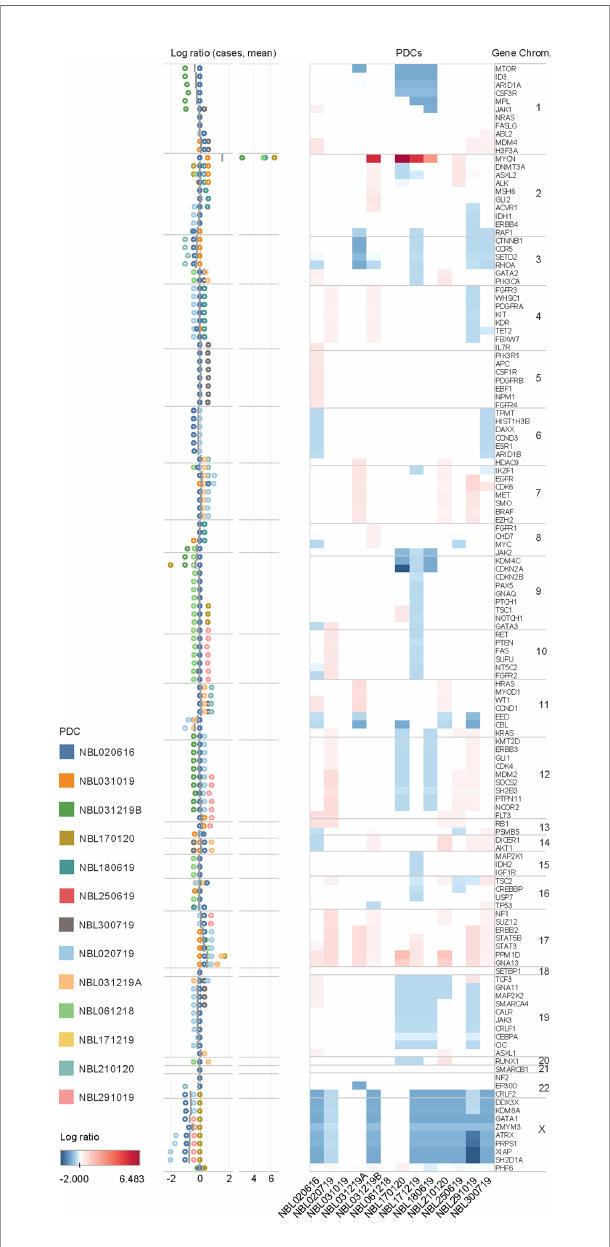
FIGURE 2 | Copy number variations in neuroblastoma. Copy number log ratio alterations of 136 genes in 13 neuroblastoma tumor samples in upper panel, and distribution of log ratios of individual cases (circles) and mean log ratios (horizontal bars) in lower panel. Mean copy number losses are observed in chromosomes 1p (MTOR, ID3, ARID1A, CSF3R, MPL, JAK1), 3p (CCNB1, CCR5,SETD2, RHOA), 8q (JAK2), 9p (KDM4C, CDKN2A), and 11q (EED, CBL); with mean gains in chromosomes 7 (EGFR, CDK6), and 17 (STAT5B, STAT3, PPM1D, GNA13). Gains are in red and losses in